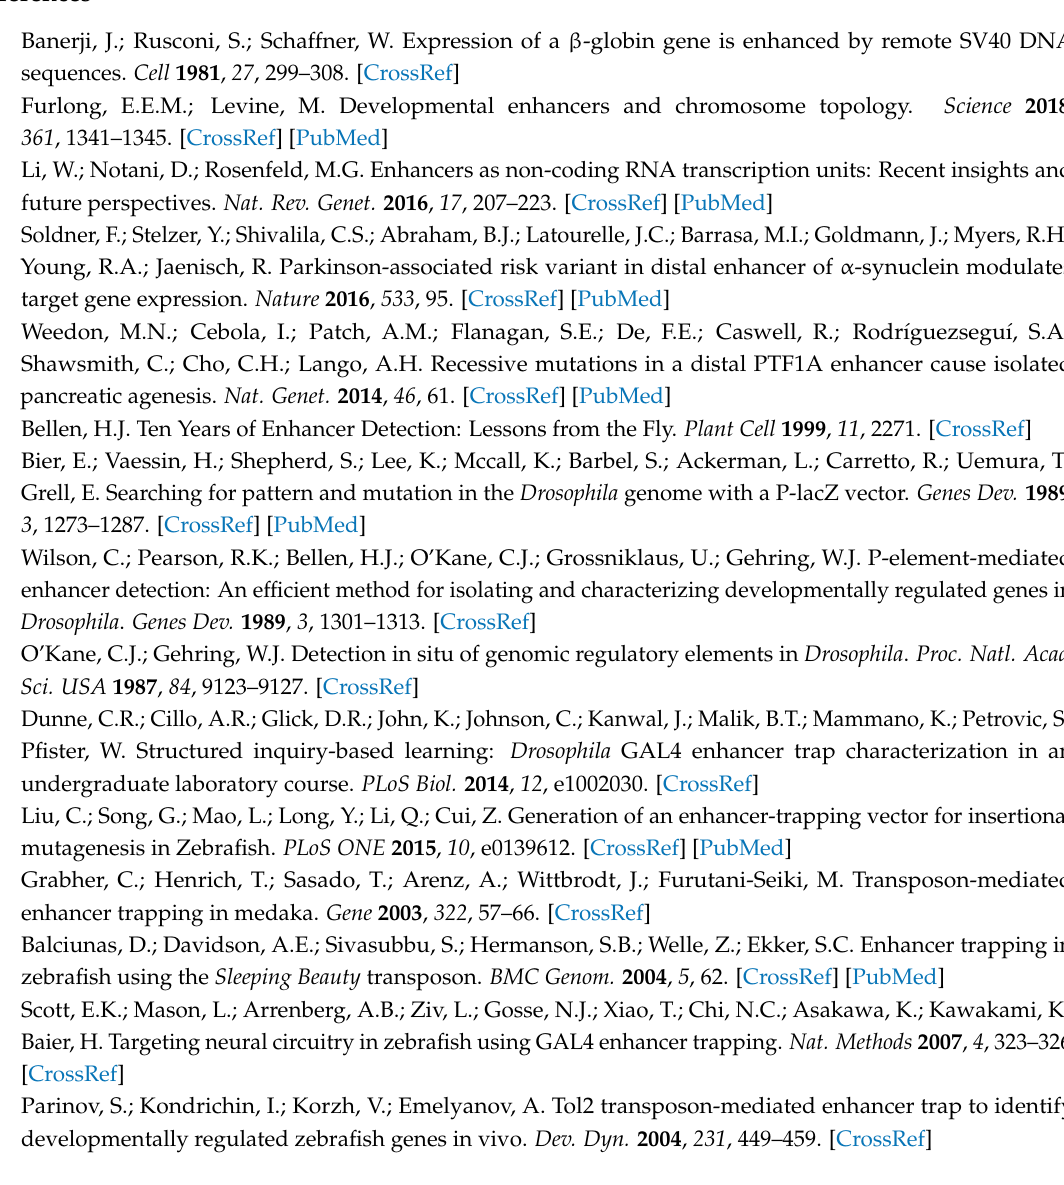
Figure S1: Representative GFP expression patterns of F1 embryos. (a–e) GFP expression of lines TK1, TK4, SK1, SK3 and PK0 at various developmental stages (1 dpf, 2 dpf, 3 dpf, 4 dpf and 5 dpf), respectively. Table S1. Primers used for the splinkerette PCR assay and En cloning, Table S2: Primers used for qPCR to investigate the transcription of the identified Ens and endogenous